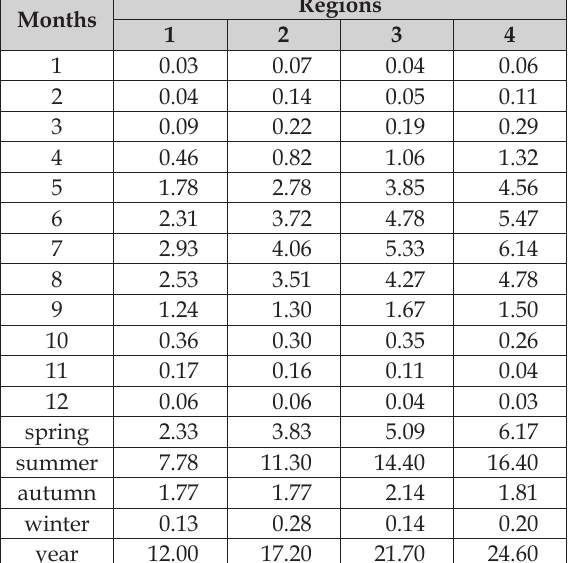
Table 1. The frequency of days with thunderstorms in distinguished regions in months, seasons of the year and in the year. Data from the period 1951–2008.